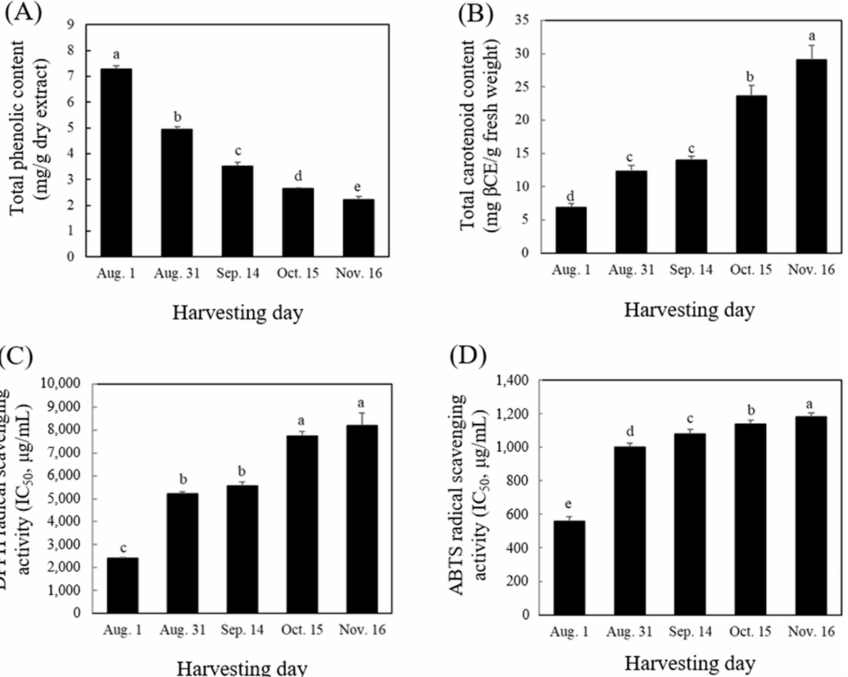
Figure 2. Total phenolic content ( A ), total carotenoid content ( B ), and antioxidant activities (DPPH ( C ) and ABTS ( D )) of Citrus unshiu flesh during fruit development. The scavenging activities of DPPH and ABTS radicals were expressed as half maximum inhibitory concentration (IC 50 ). The different letters in each bar indicate significant difference by Duncan’s test at p <